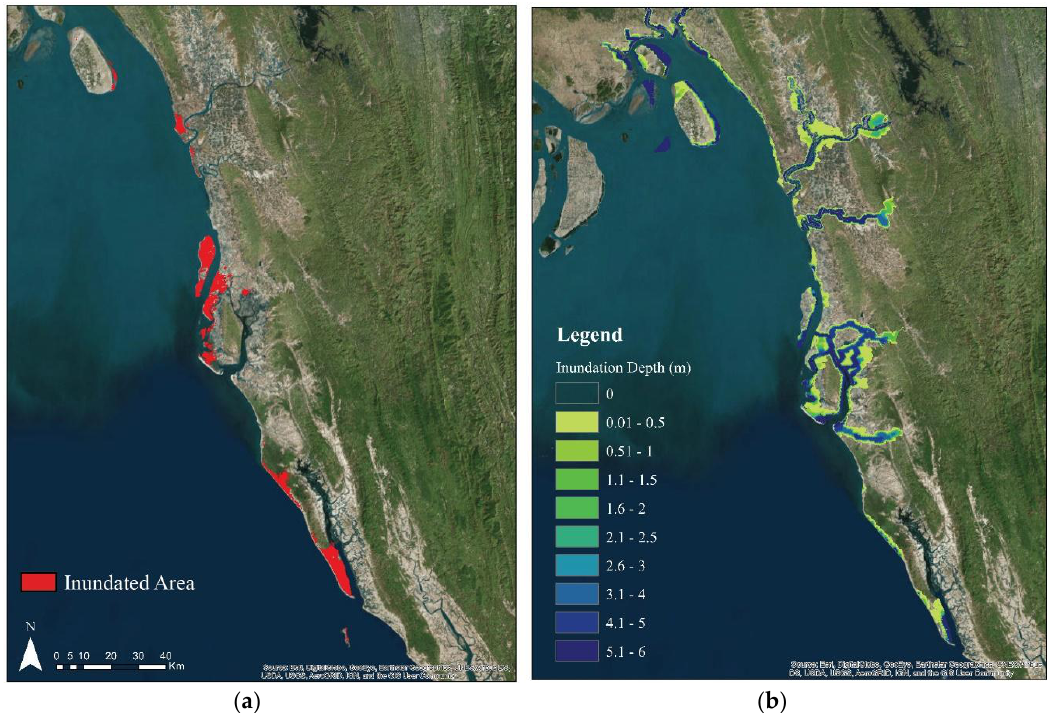
Figure 5. Comparison of the inundation scenarios from ( a ) the MODIS satellite imagery and ( b ) model simulation. Based on a one-to-one function comparison, the inudated area from the image and from the model shows a 60% match.